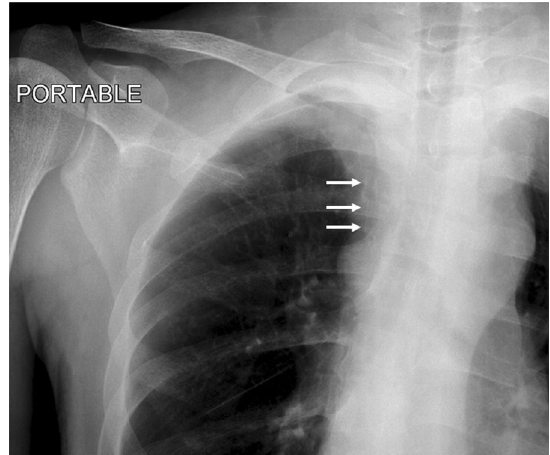
Fig. 4 Retrospective examination of the initial chest radiograph showed a faint calcified tubular structure in the right paratracheal region (white arrows) corresponding to the calcified fibrin